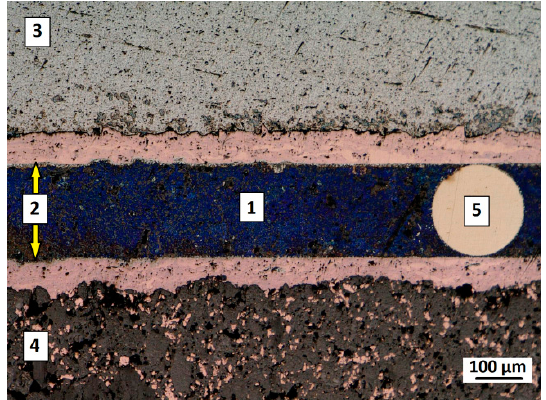
Figure 7. Cross-section presenting microstructure of soldered joints: 1—solder; 2—Cu coating; 3—6060 aluminum alloy; 4—graphite composite; 5—steel distance wire.